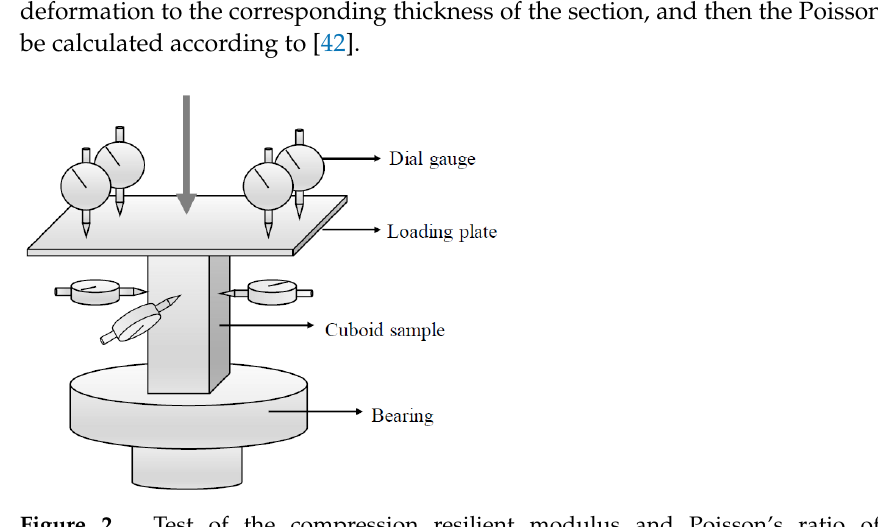
Figure 2. Test of the compression resilient modulus and Poisson’s ratio of transverse isotropy materials.